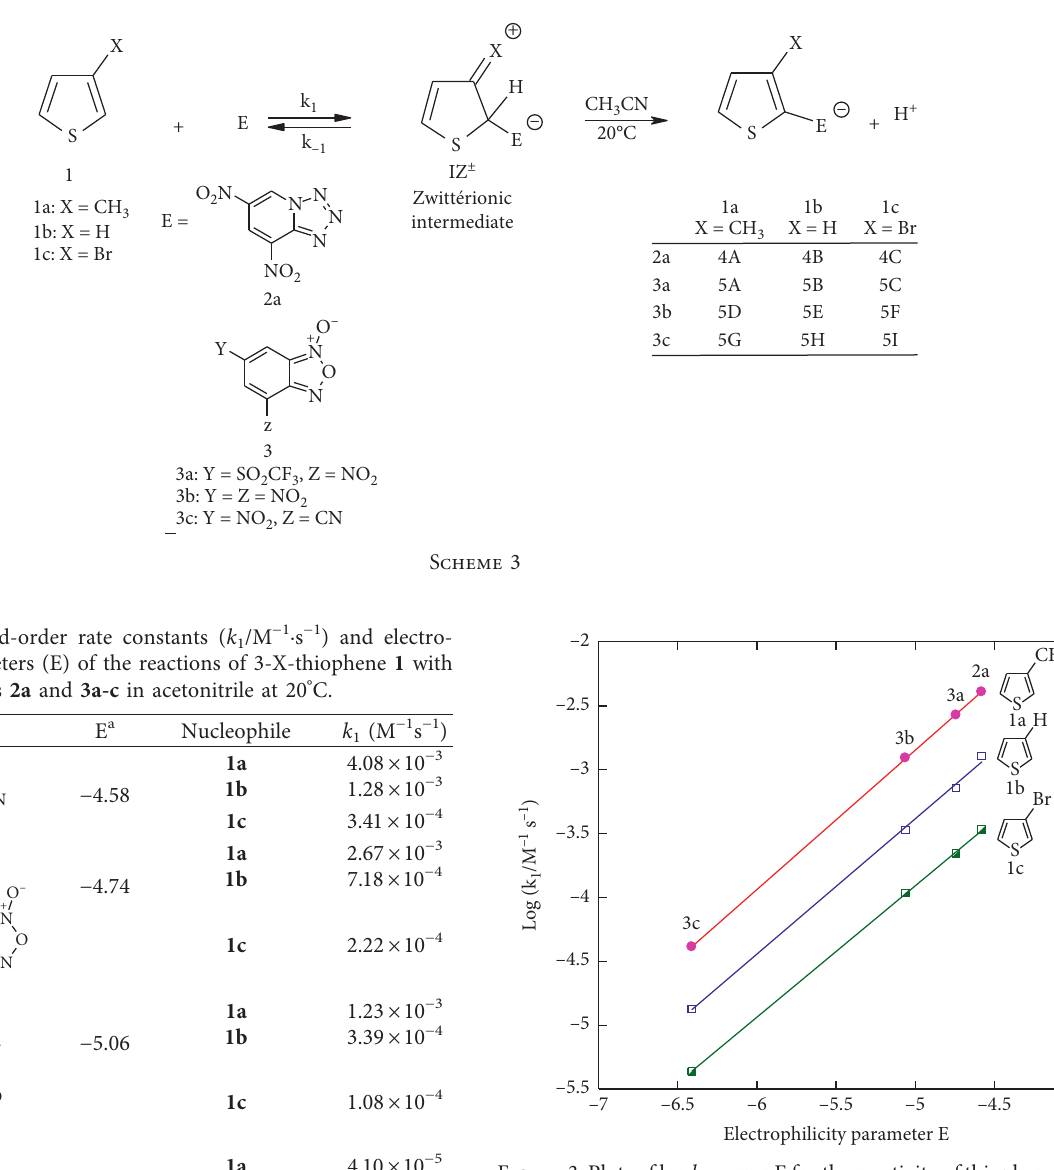
Figure 3: Plots of log k 1 versus E for the reactivity of thiophenes 1a- c with the reference electrophiles 2a and 3a-c in acetonitrile at 20 ° C (the identity of points is given in Table